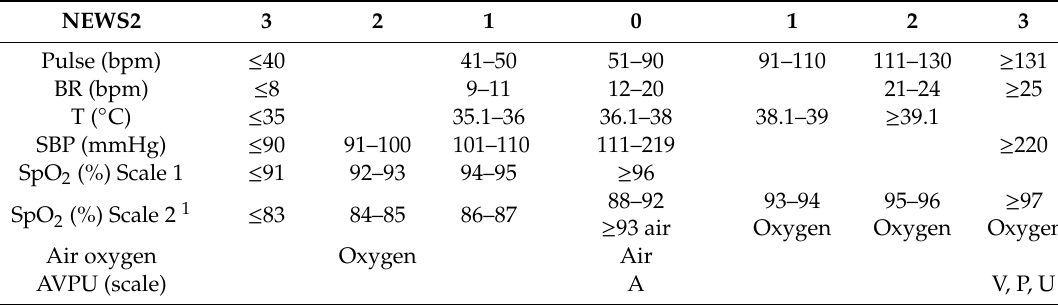
Table 1. National Early Warning Score 2